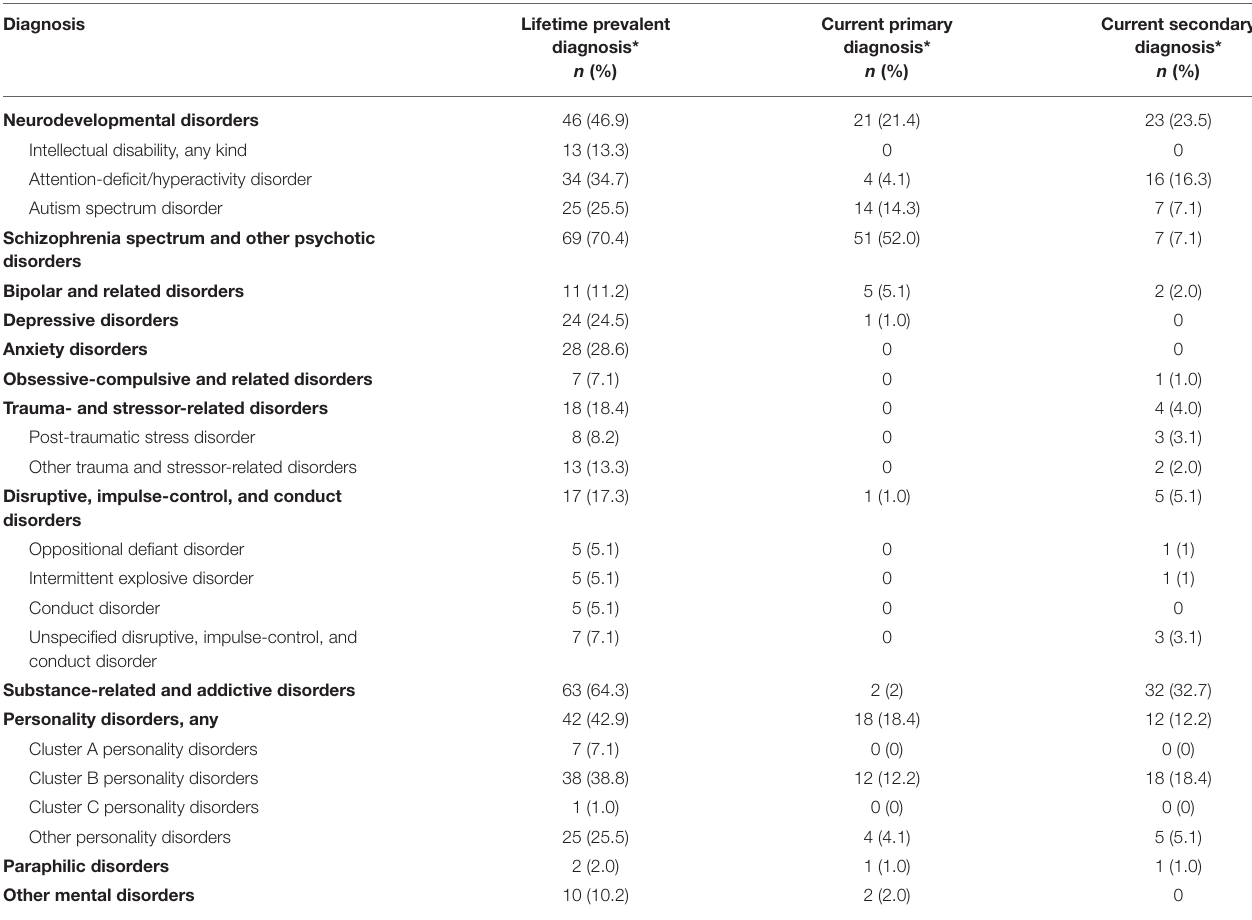
TABLE 3 | Current and historical mental disorders in forensic psychiatric